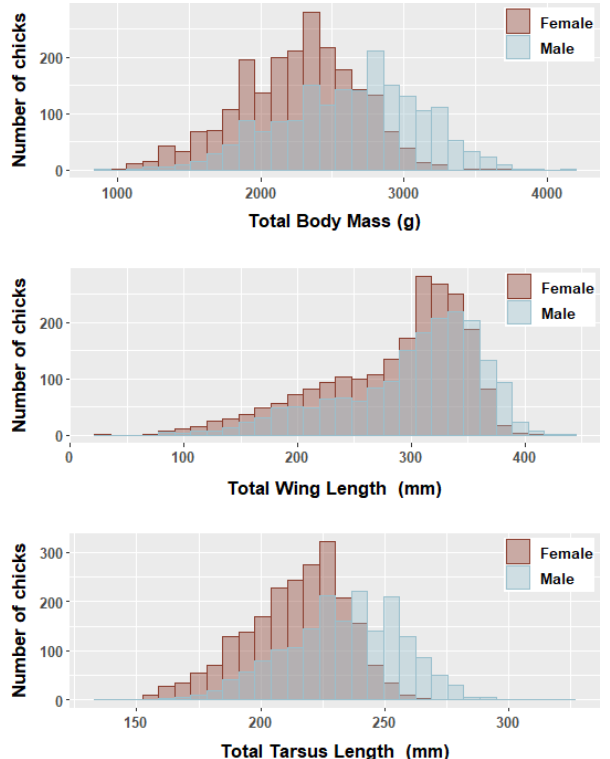
Figure 1. Mean (body mass, tarsus and wing length) of male and fe- male greater flamingo chicks banded at Camargue, during 11 breed- ing seasons (1995–2008, except 2001, 2002 and 2007).